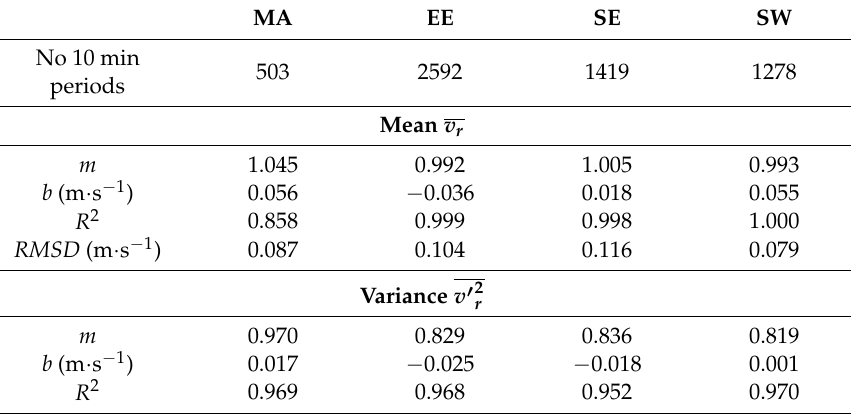
Table 2. Summary of the inter-comparison of the radial velocities of the WindScanners and the sonic anemometer at 188 m; RMSD indicates the root-mean-square deviation; R 2 is the goodness of the fit, m is the slope and b the intersect of the of the linear